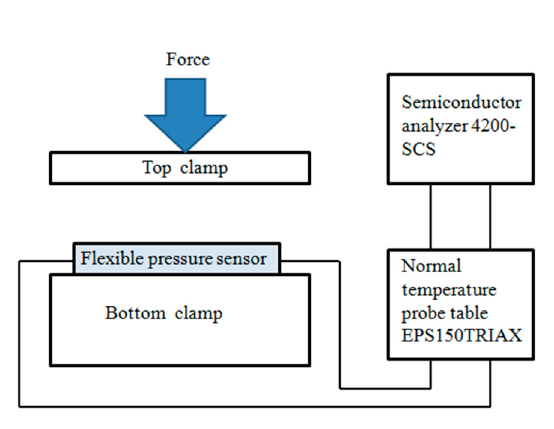
Figure 6. The diagram of testing system for flexible pressure sensor.